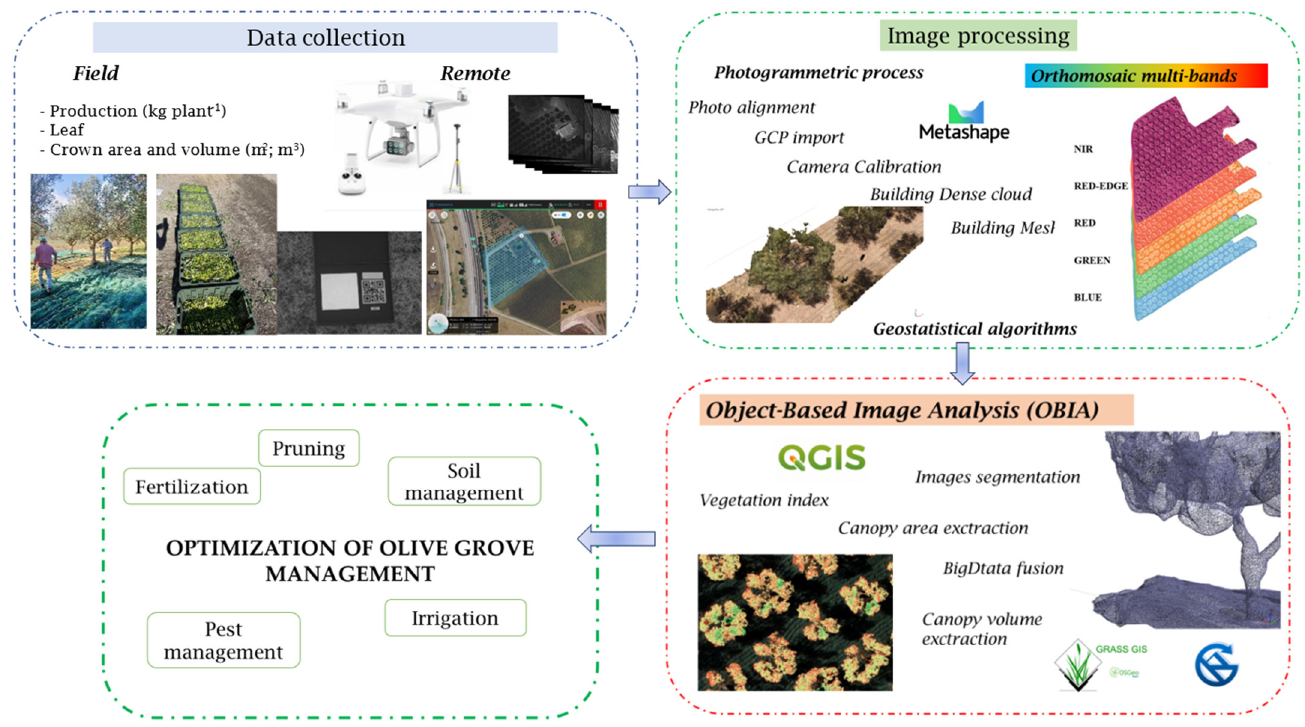
Figure 3. Overall flowchart of the experimental